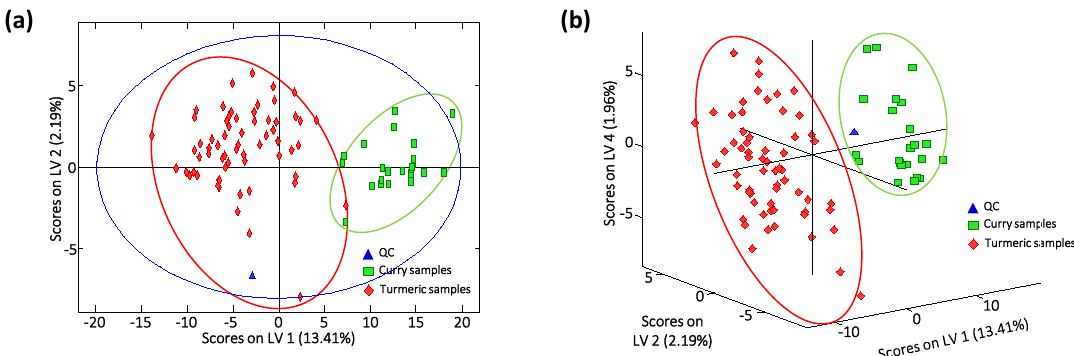
Figure 4. Partial least square regression-discriminant analysis (PLS-DA) score plots of ( a ) LV1 vs. LV2 and ( b ) LV1 vs. LV2 vs. LV4 by non-targeted UHPLC-HRMS using selected fingerprint features as sample chemical descriptors for the classification of the analyzed samples. Four latent variables (LVs) were required to build the models.